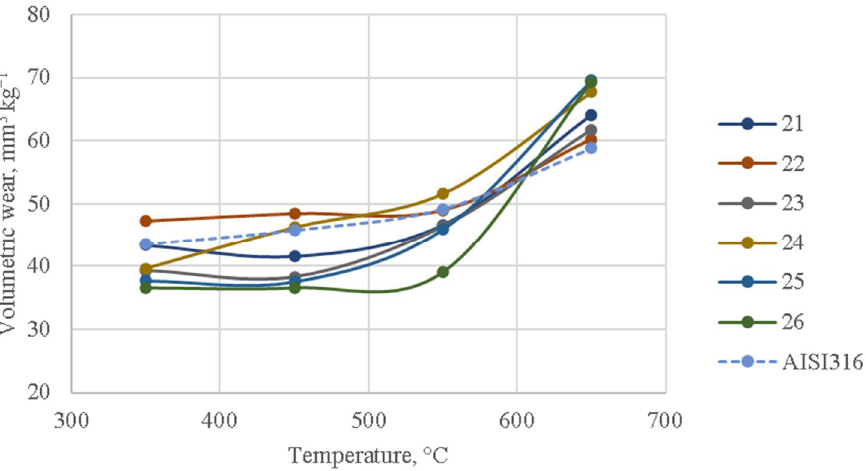
Figure 11. Effect of temperature on erosion wear of hardfacings with thermal treatment and AISI 316 steel (impact angle 30°; velocity 80 m s −1 ).